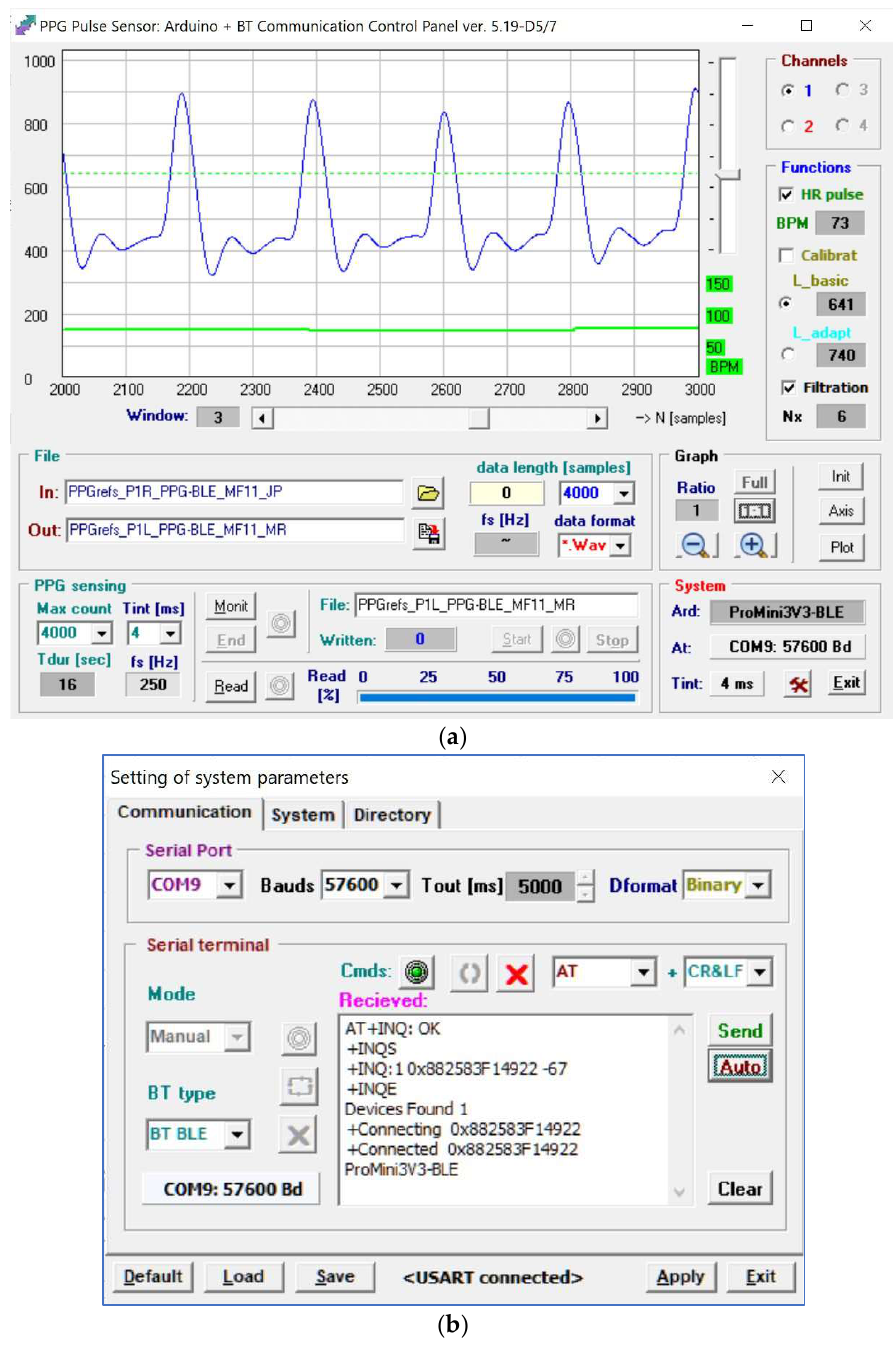
Figure 8. Screen copy of the control application PPGsens7BT v.5.19: ( a ) main operating window with a displayed PPG wave (4th frame of 4-k sample data block, f S = 250 Hz) and a determined mean HR value in beats per minute, ( b ) the parameter setting window documenting the process of BT connection creation with the PPG-BLE sensor based on the BT module MLT-BT05.